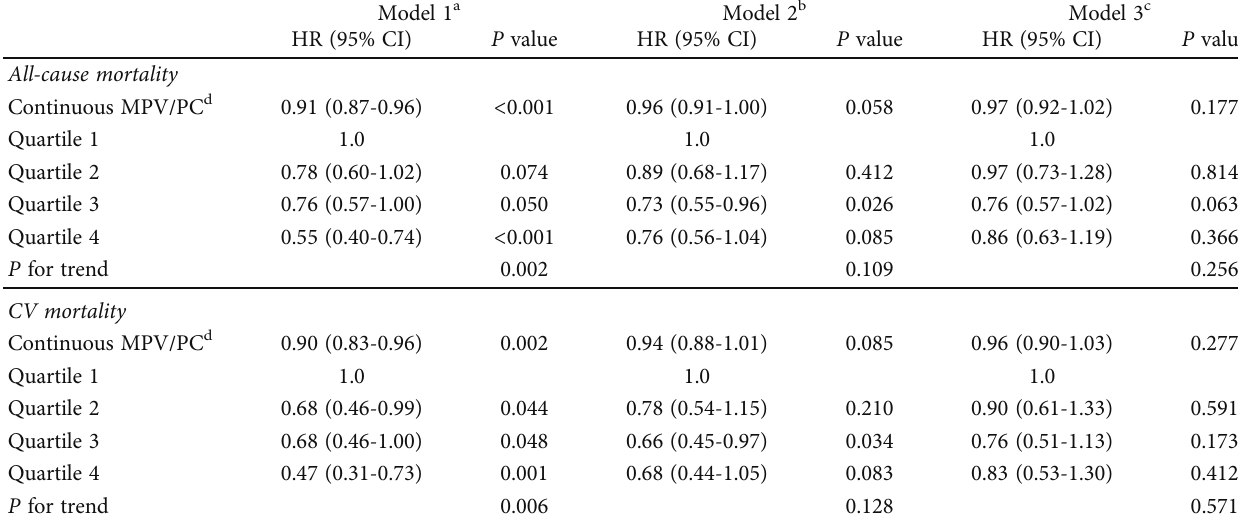
Table 3: The association of MPV/PC with all-cause and CV mortality in PD patients.